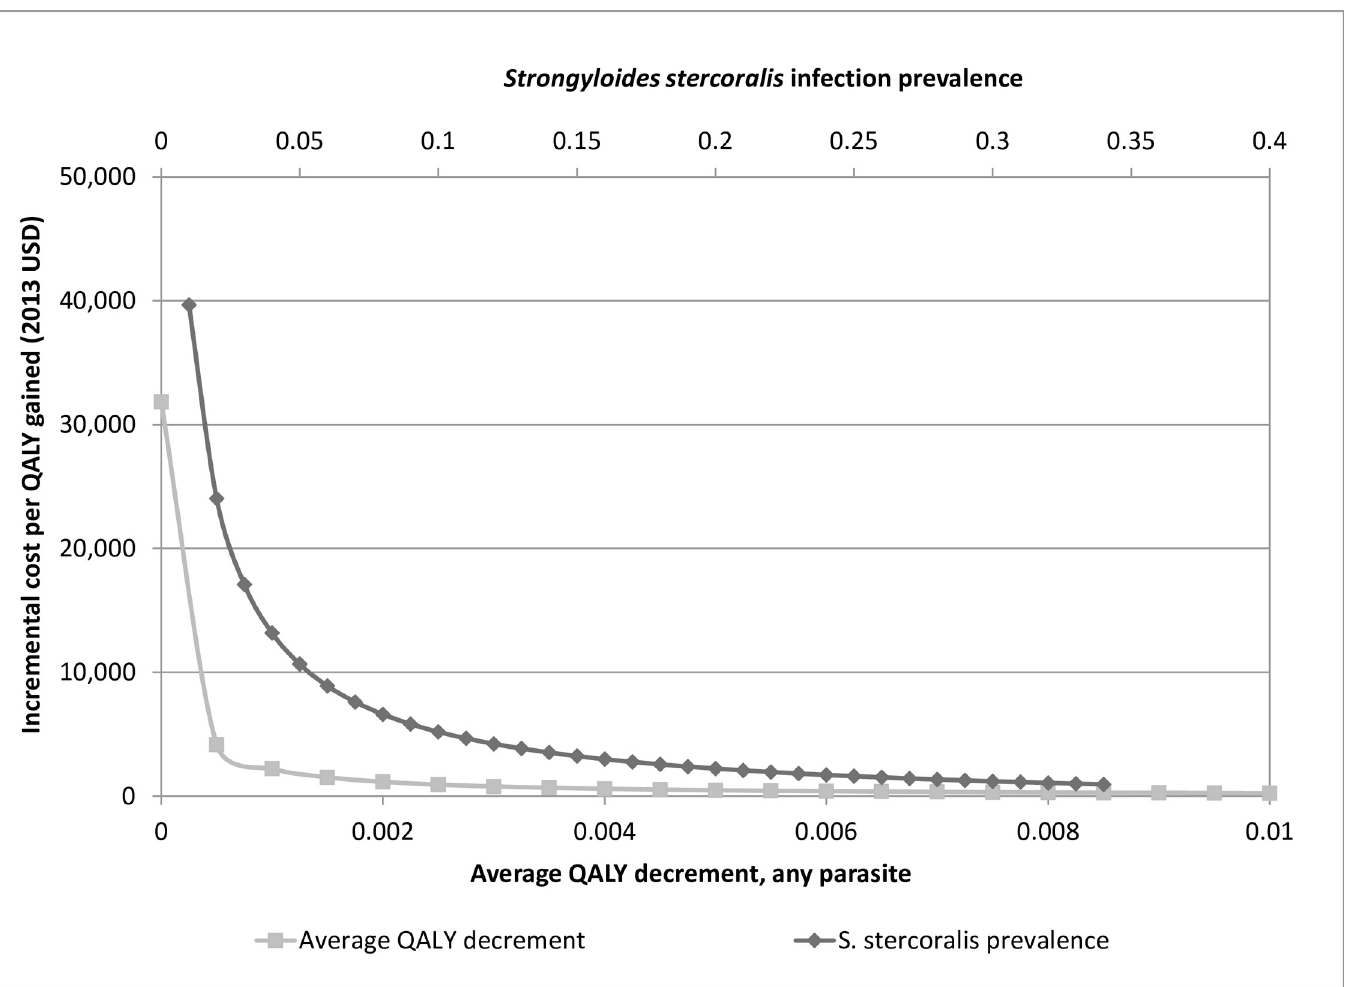
Fig 1. One-way sensitivity analyses of Strongyloides infection prevalence and QALY decrement on the cost per QALY gained, “ Overseas Albendazole and Ivermectin ” compared to “ No Program ” (2013 USD).